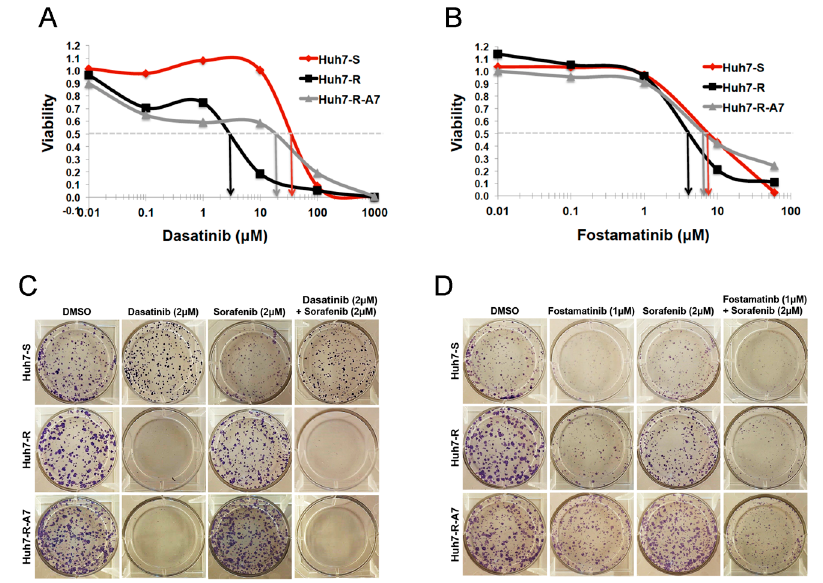
Figure 3. Validation of predicted drug candidates for action against sorafenib resistant HCC. Increased sensitivity of sorafenib-resistant Huh7 cells to dasatinib ( A ) and fostamatinib ( B ), as measured 48 h post-treatment using CellTiter-Glo viability assay. Growth of sorafenib-resistant Huh7 cells is inhibited by dasatinib ( C ) and fostamatinib ( D ), alone and in combination with sorafenib, as measured by colony formation assay 2 weeks post-treatment.